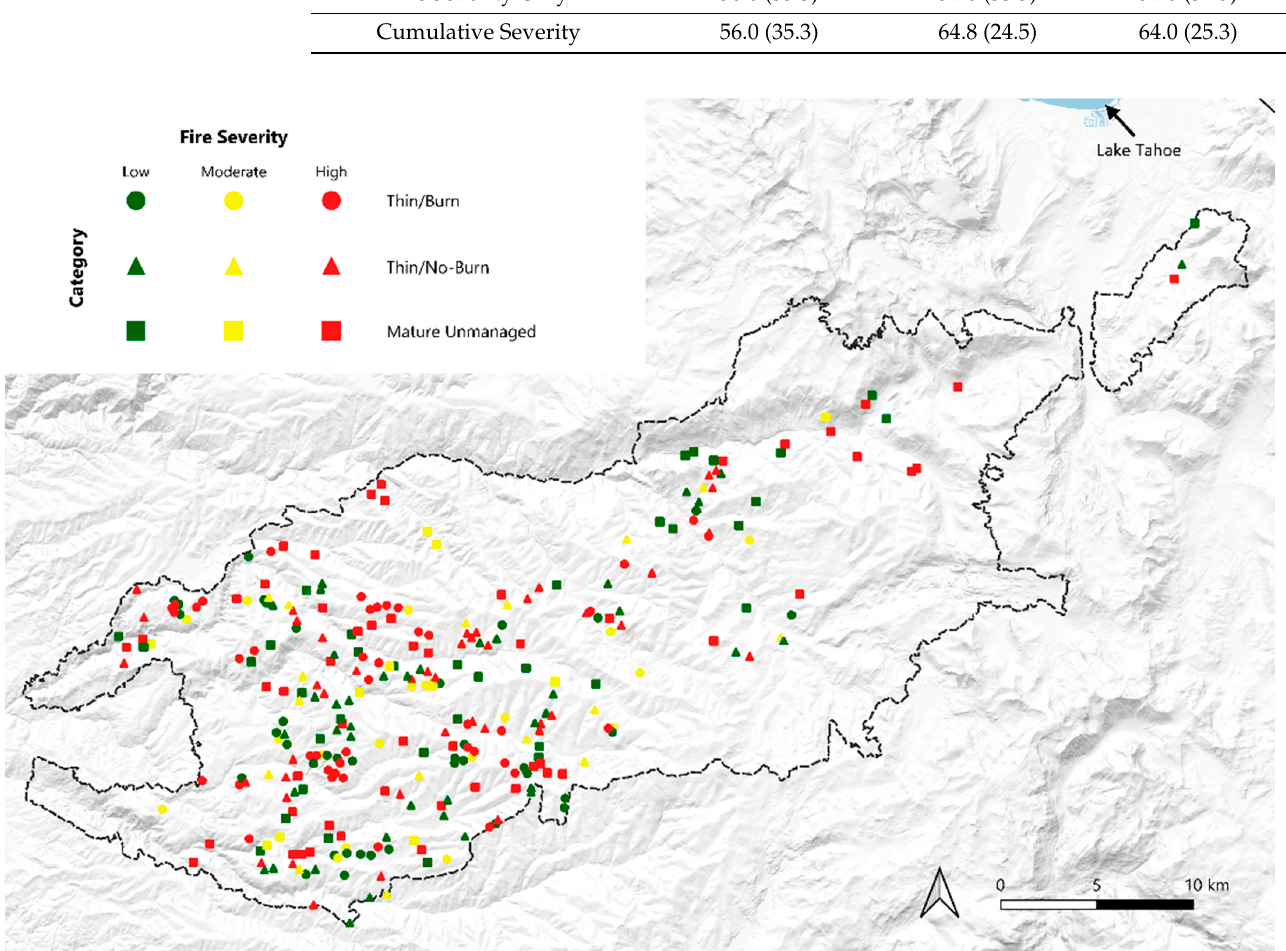
Figure 2. Sample pixel locations for each management category, with colors corresponding to RAVG fire severity categories (with the two lowest severity categories in the BA4 dataset combined into a single low category as described in the